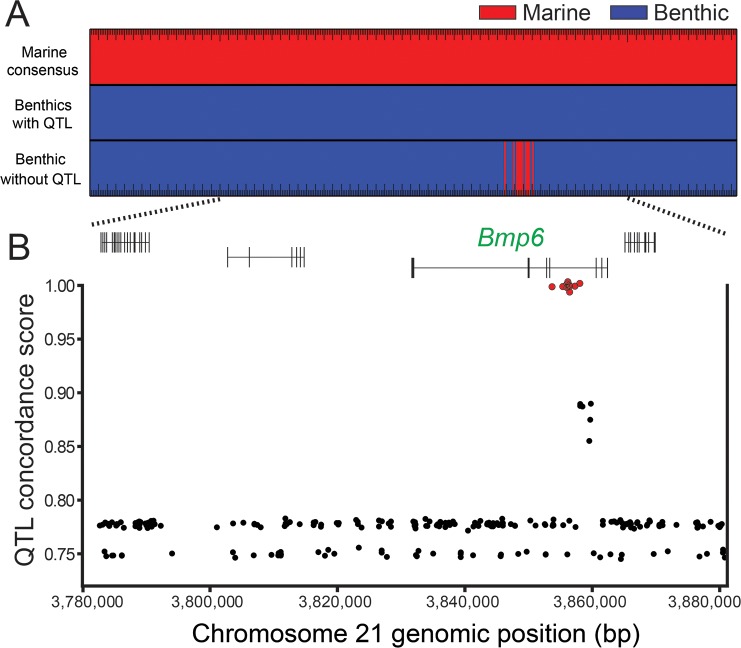
Comparative genomics reveal QTL-associated variants in intron 4 of Bmp6.(A) Comparing genomic sequences of the fine-mapped tooth QTL (from Fig 1C) between marine (n = 3, from crosses 2, 5, and 6) and benthic chromosomes with the tooth QTL (n = 7, from crosses 1–5) identified a set of variants with opposite homozygous genotypes, colored red for marine (top) and blue for benthic (middle). Note that only positions with opposite homozygous genotypes within this 884 kb are shown. The benthic chromosome without the QTL (chromosome B8 from cross 6) had a cluster of variants sharing the consensus marine genotype (bottom). (B) The ten variants with perfect QTL association (red points) all lie within intron 4 of Bmp6. The y-axis shows QTL concordance score (see Methods), a metric of concordance between genotype and presence or absence of tooth QTL. Gene model of Bmp6 and surrounding genes are based on Ensembl predictions [24].